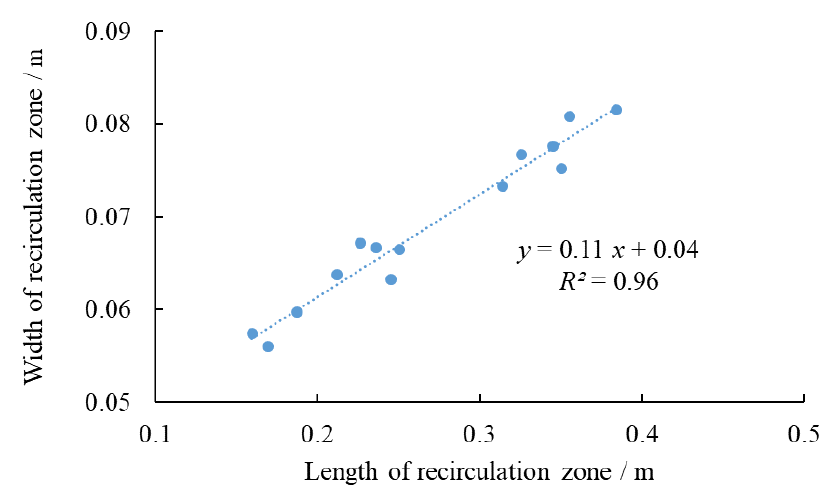
Figure 12. Relationship between the length and width of the recirculation zone behind Groin A.